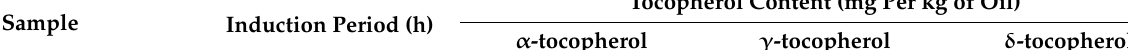
Table 3. Induction period and tocopherol content of the lipid phase extracted from aubergine salad (AS) samples and control sample (soybean oil); superscript letters denote statistically significant differences ( p < 0.05) within a